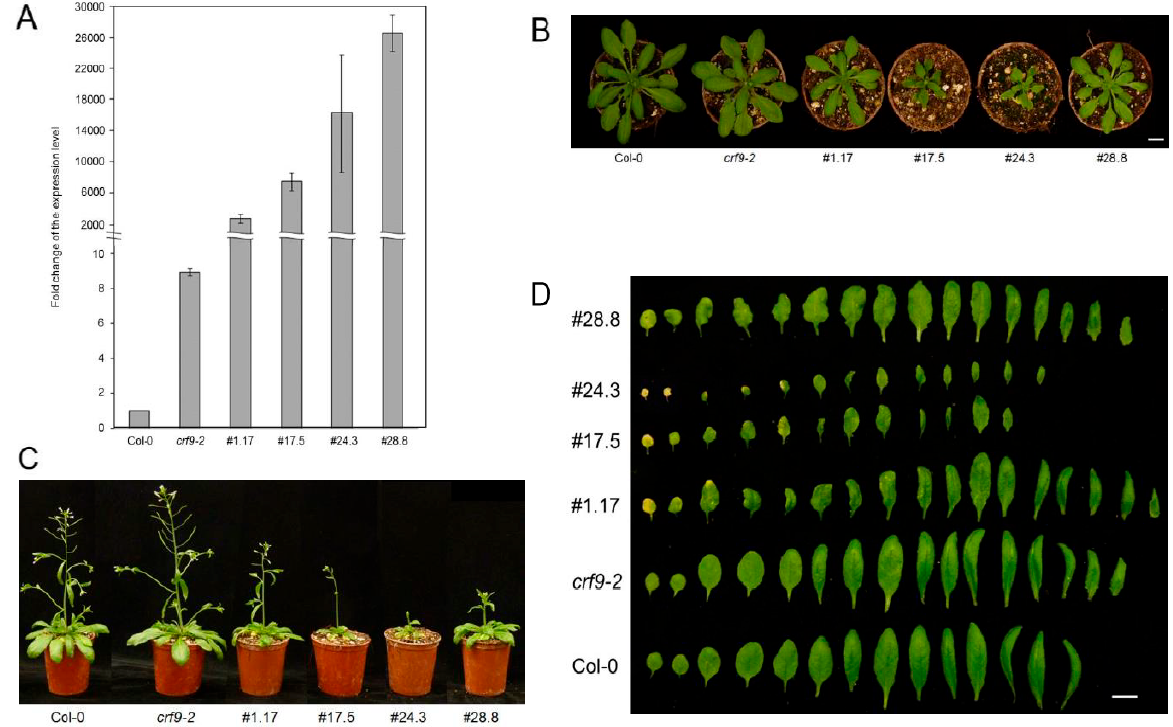
Figure 4. Analysis of the phenotype of CRF9 mutants. Plants of the wild-type Col-0, crf9-2 , and four independent CRF9 overexpressing lines were grown at long-day conditions in the greenhouse. ( A ) The CRF9 expression levels in 7-day-old seedlings were analyzed using qRT-PCR. ( B , C ) The shoot phenotype of the plants 28 days after germination. ( D ) Leaves of the different plant lines were used in this study at the time of floral transition.